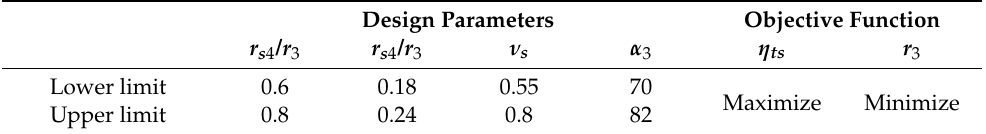
Table 4. Adopted limits of the design